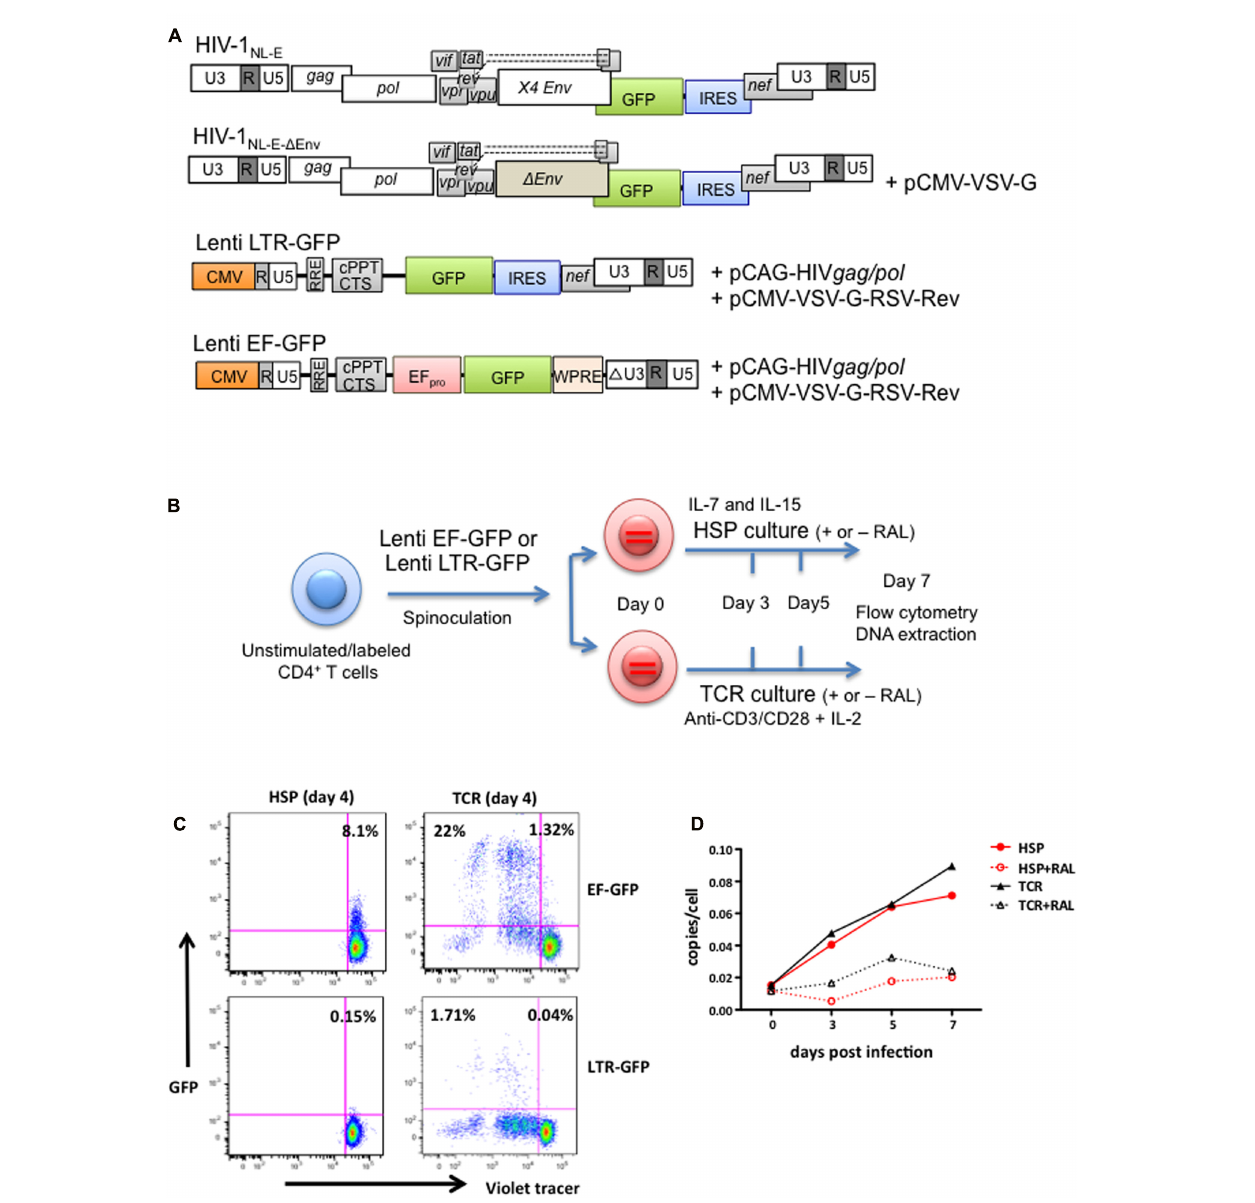
FIGURE 2 | HIV LTR-dependent expression of a GFP marker gene is differentially influenced by HSP and TCR culture of lentivirus-infected CD4 + T cells. (A) Structure of the parental GFP-expressing HIV-1 NL − E vector and its derivatives used in this study: HIV-1 NL − E − (cid:49) Env , Lenti LTR-GFP (encoding LTR-driven GFP) and Lenti EF-GFP (encoding EF-1 α promoter-driven GFP). Plasmid names used for co-transfection for virus production are given. See “Materials and Methods” for details on vector generation. (B) Experimental strategy outline. Purified, unstimulated, Violet tracer-labeled CD4 + T cells were spinoculated with Lenti LTR-GFP or Lenti EF-GFP, and cultured under HSP or TCR conditions. (C) EF promotor- or LTR-driven marker gene expression under HSP culture or TCR conditions. Infected and cultured cells were analyzed for GFP expression and proliferation (Violet Tracer) at day 4 by flow cytometry (HSP culture; left panel and TCR culture; right panel). A representative plot from four different donors is shown. (D) Lentivirus-infected CD4 + T cells show similar levels of vector integration under HSP and TCR culture conditions. CD4 + T cells were infected as under (B) , cultured in the presence or absence of integrase inhibitor Raltegravir (RAL) and collected at days 0, 3, 5, and